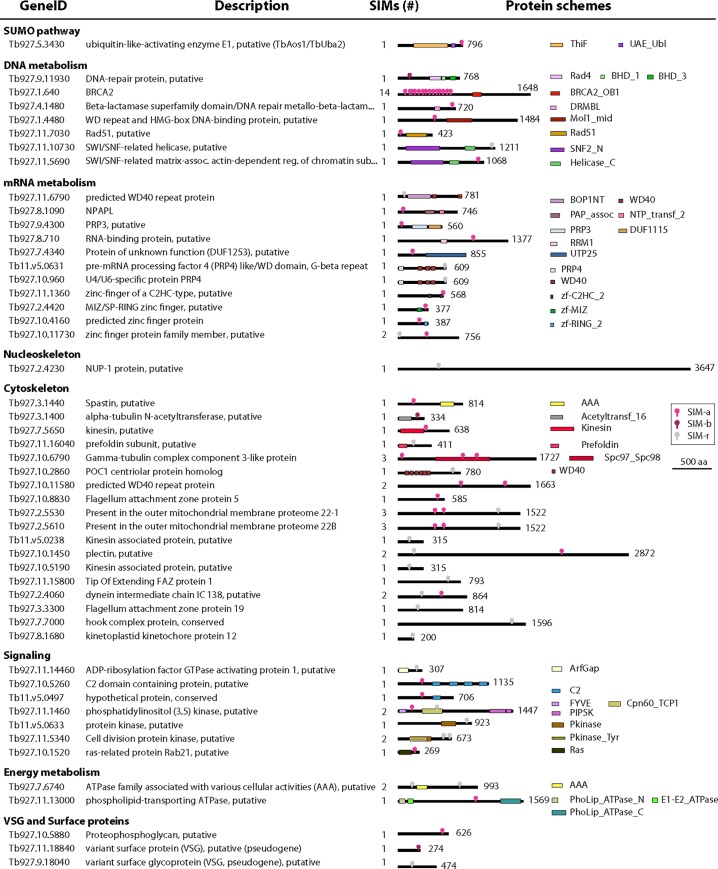
Biological classification of good SIM candidate proteins in T. brucei.Sequences were identified in the translated proteome using a combination of search methods (see text) and 50 out of 102 hits were classified into functional categories according to their genome annotation or protein domains detected by PFAM database (http://pfam.sanger.ac.uk). GeneID, protein description, total number of SIMs and a scheme of the domains (in scale) are shown. Location of the SIM within each sequence is shown in coloured dot shape: magenta, SIM-a; bourdeux, SIM-b and light gray, SIM-r. Length of the proteins (in residues) are also summarized.